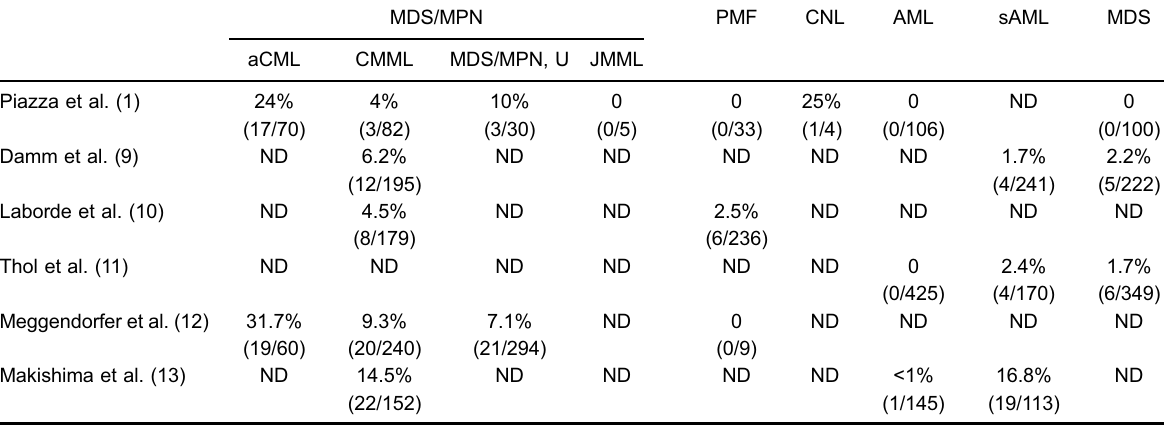
Table 1. Incidence of SETBP1 mutations in hematological diseases, as reported in the